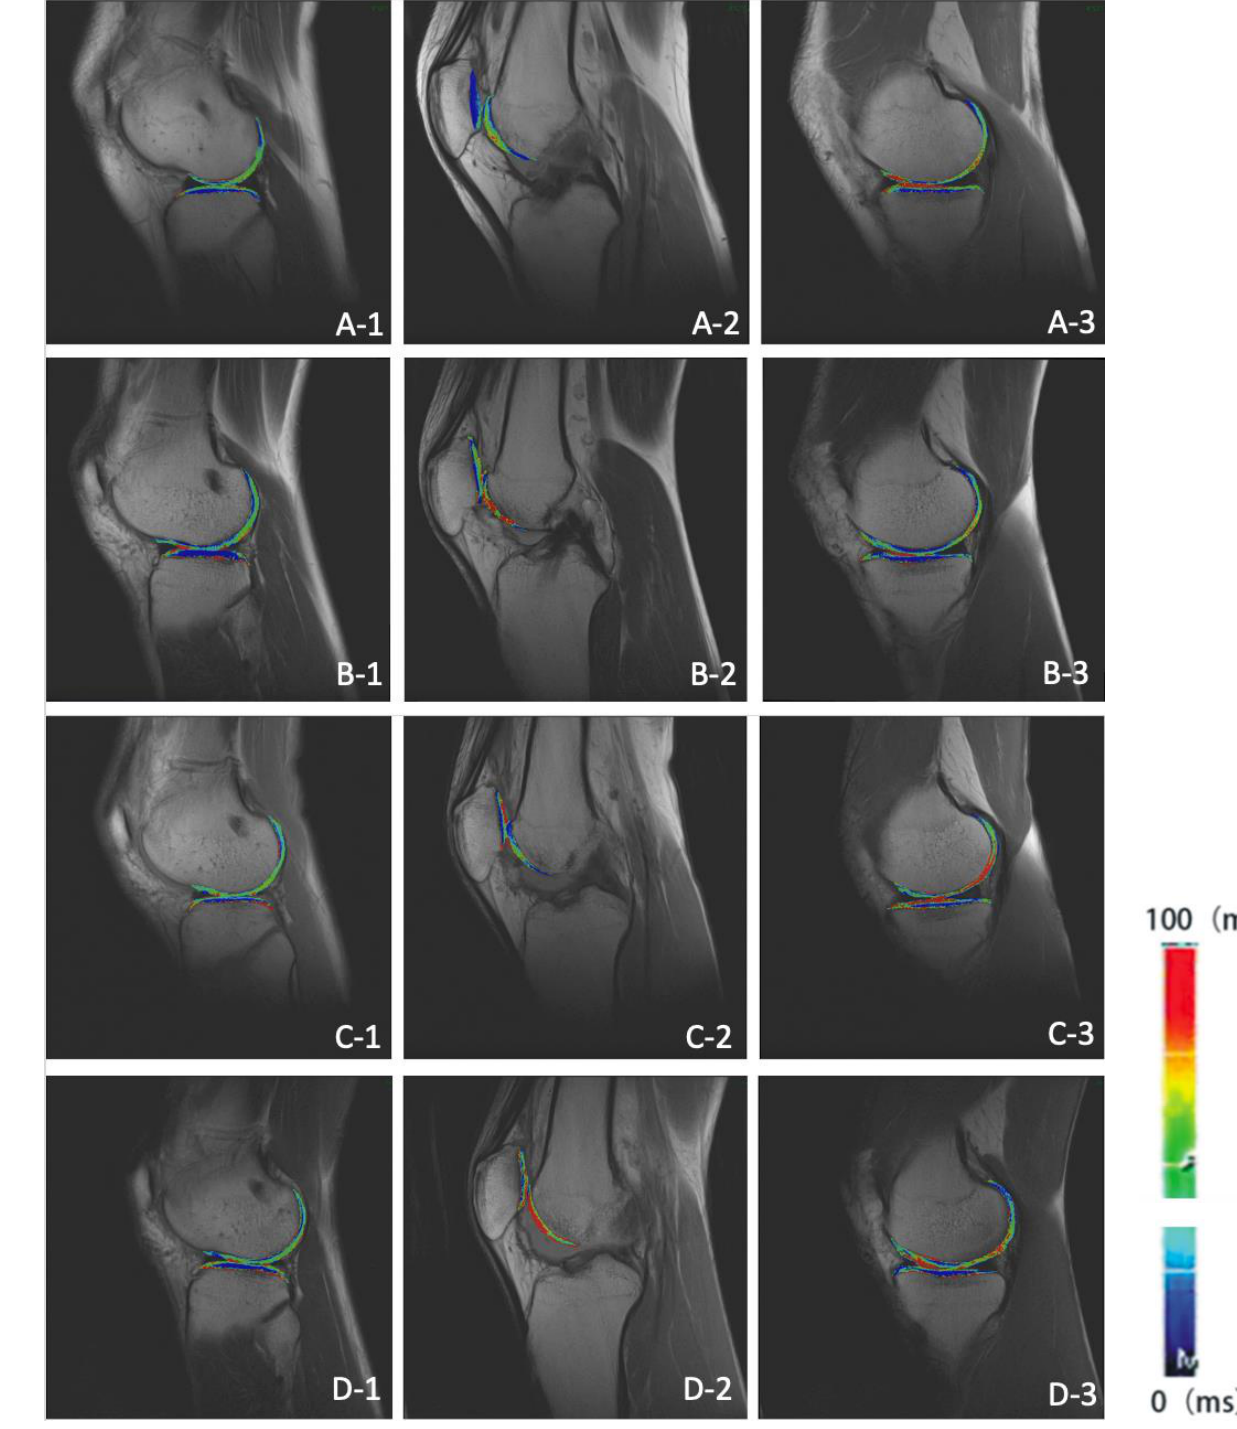
Figure 6. T2 mapping of knee joint sagittal plane in FHT group. ( A-1 – A-3 ) show the lateral tibiofemoral joint, patellofemoral joint and medial tibiofemoral joint at 6 months after operation in FHT group; ( B-1 – B-3 ) show the lateral tibiofemoral joint, patellofemoral joint and medial tibiofemoral joint 12 months after operation in FHT group; ( C-1 – C-3 ) show the lateral tibiofemoral joint, patellofemoral joint and medial tibiofemoral joint 24 months after operation in FHT group; ( D-1 – D-3 ) show the lateral tibiofemoral joint, patellofemoral joint and medial tibiofemoral joint in FHT group 60 months after operation.